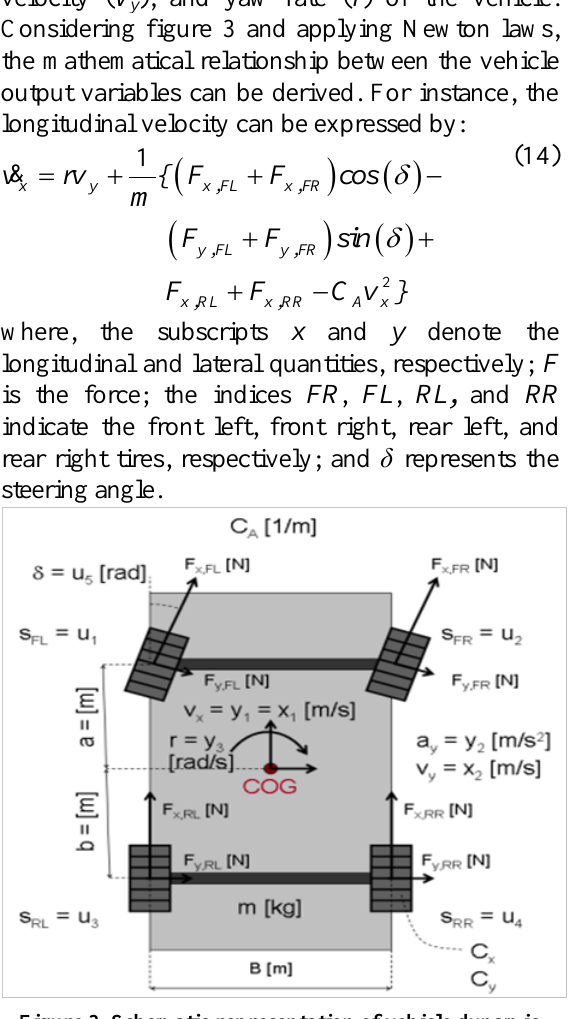
Figure 3. Schematic representation of vehicle dynamic